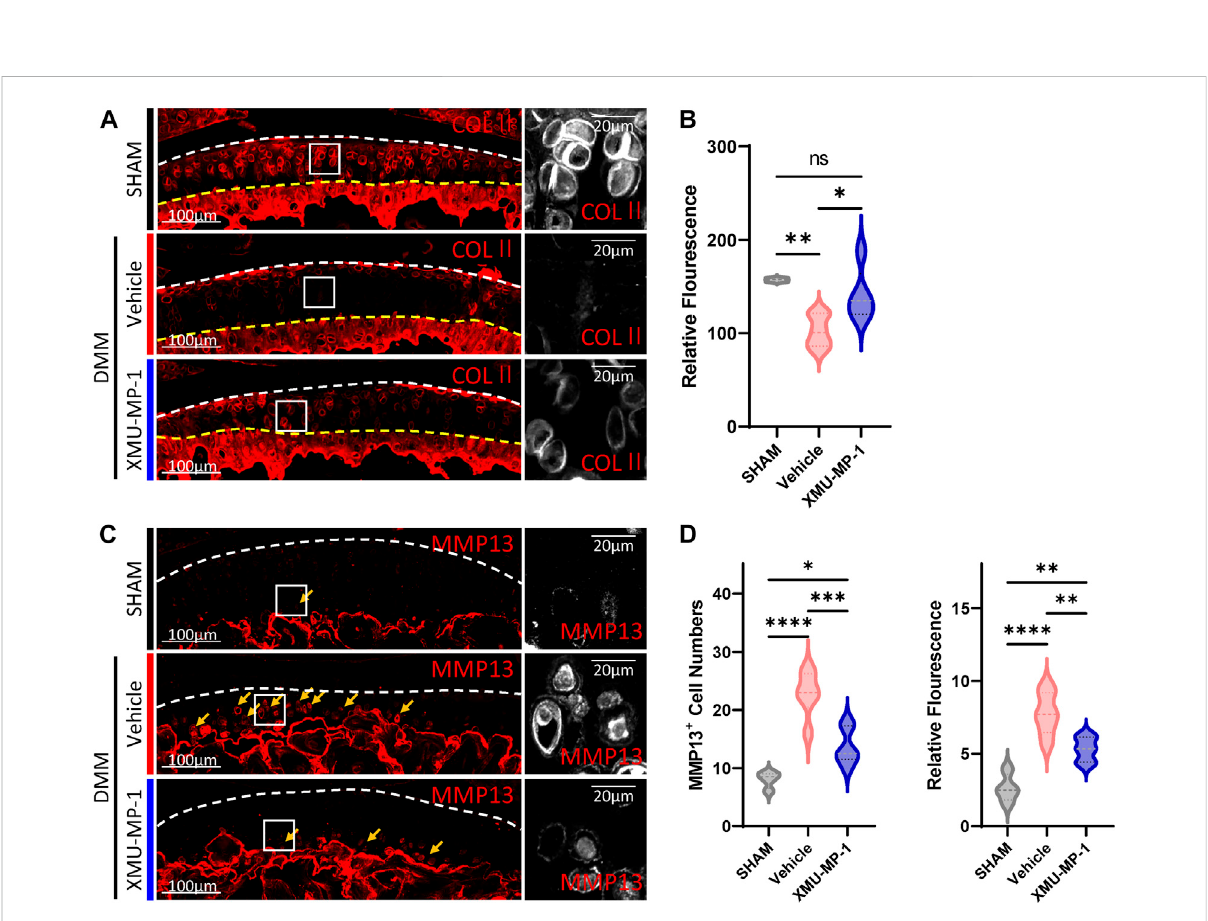
FIGURE 5 XMU-MP-1 attenuates articular cartilage degradation during OA pathogenesis. (A) Representative images of knee joint sections of mice from indicated groups. SHAM: Mice underwent sham surgery. Vehicle: Mice undergoing DMM surgery were intraperitoneally injected with vehicle. XMU- MP-1: Mice undergoing DMM surgery were intraperitoneally injected with XMU-MP-1. Sections were immunostained with antibody against COL Ⅱ (redorgray).Panelsontherightarehighmagni fi cationsofboxedregionsintheleftpanels.Thewhitedashedlinesmarkedtheedgeofcartilage. The yellow dashed lines marked the tidemark. (B) Statistical analysis of the relative fl uorescence of COL Ⅱ in hyaline cartilages in A. n = 3, 6, 5. (C) Representative images of knee joint sections of mice from indicated groups. SHAM: Mice underwent sham surgery. Vehicle: Mice undergoing DMM surgery were intraperitoneally injected with vehicle. XMU-MP-1: Mice undergoing DMM surgery were intraperitoneally injected with XMU-MP-1. Sections were immunostained with antibody against MMP13 (red or gray). Panels on the right are high magni fi cations of boxed regions in the left panels.Thedashedlinesmarkedtheedgeofcartilage.TheyellowarrowsmarktheMMP13 + chondrocytesincalci fi edcartilage. (D) Statisticalanalysis of the MMP13 + chondrocytes numbers in articular cartilage in C. Panel on the left is quanti fi cation of MMP13 + chondrocytes numbers per cartilage. Panel onthe rightis thequanti fi cationof relative fl uorescence inMMP13 + chondrocytes. n = 3, 6, 6. All data arepresented as mean ± SEM.* p < 0.05, ** p < 0.01, *** p < 0.001, **** p <